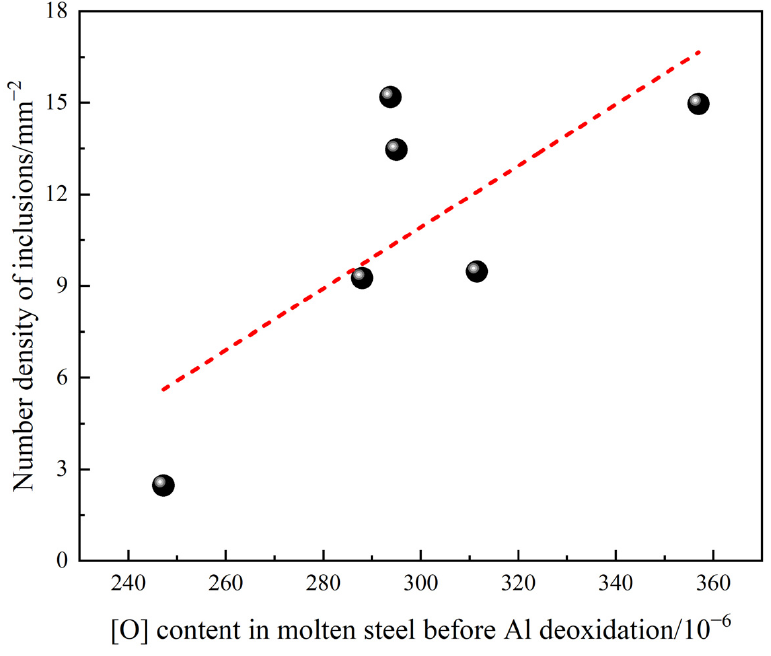
Figure 16. Relationship between the number of inclusions after RH and [O] content in molten steel before Al deoxidation.